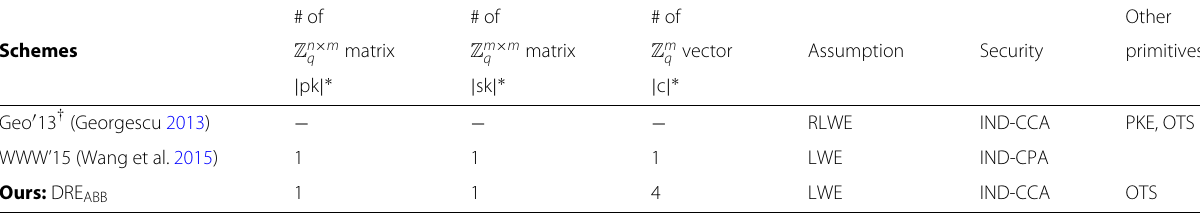
Table 1 Comparison of DRE Schemes from Lattices